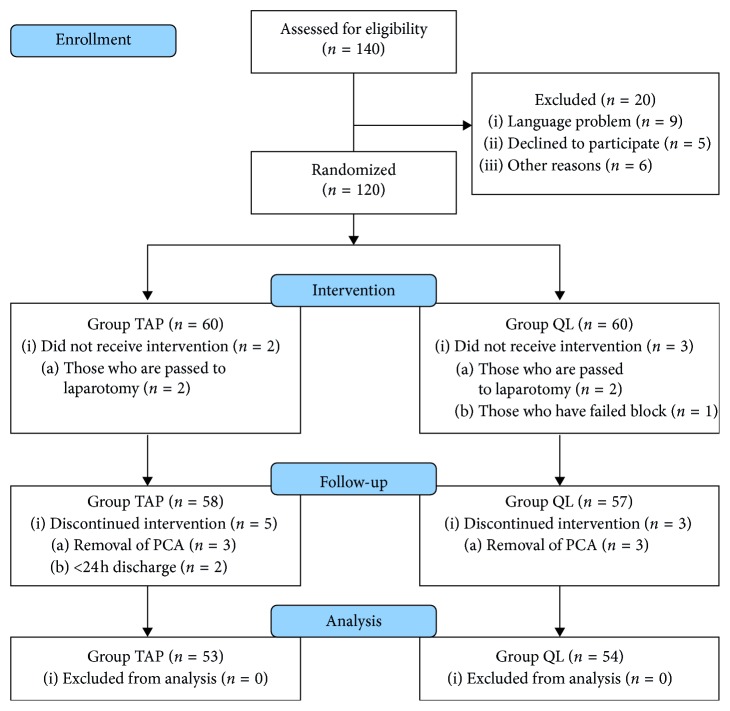
Trial flow diagram.